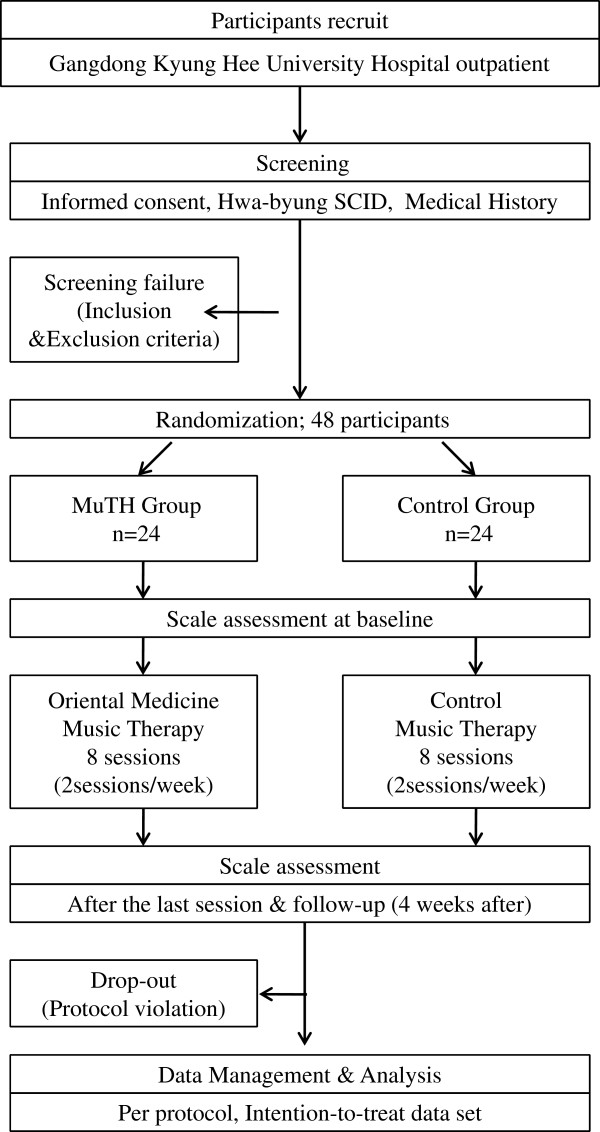
Study flow chart.